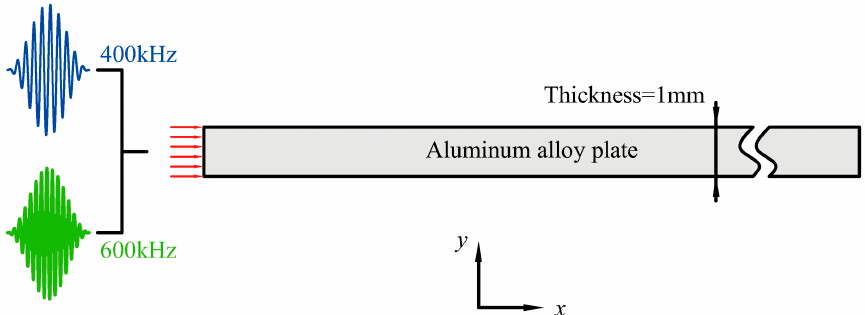
Figure 2. Schematic diagram of two-dimensional finite-element model for nonlinear mixing of S 0 modes at 400 kHz and 600 kHz.